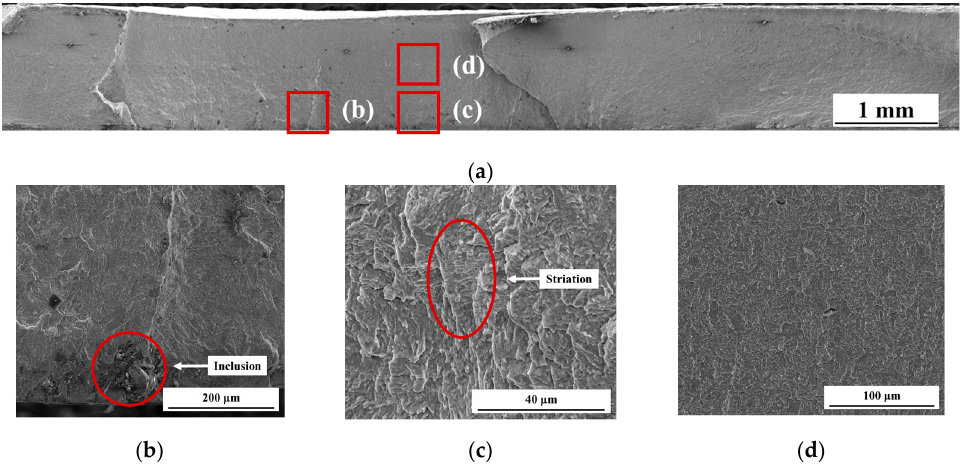
Figure 12. Fatigue fracture surface at plug failure mode: ( a ) overall view, ( b ) crack initiation area, ( c ) occurrence area of striation, and ( d ) crack propagation area.